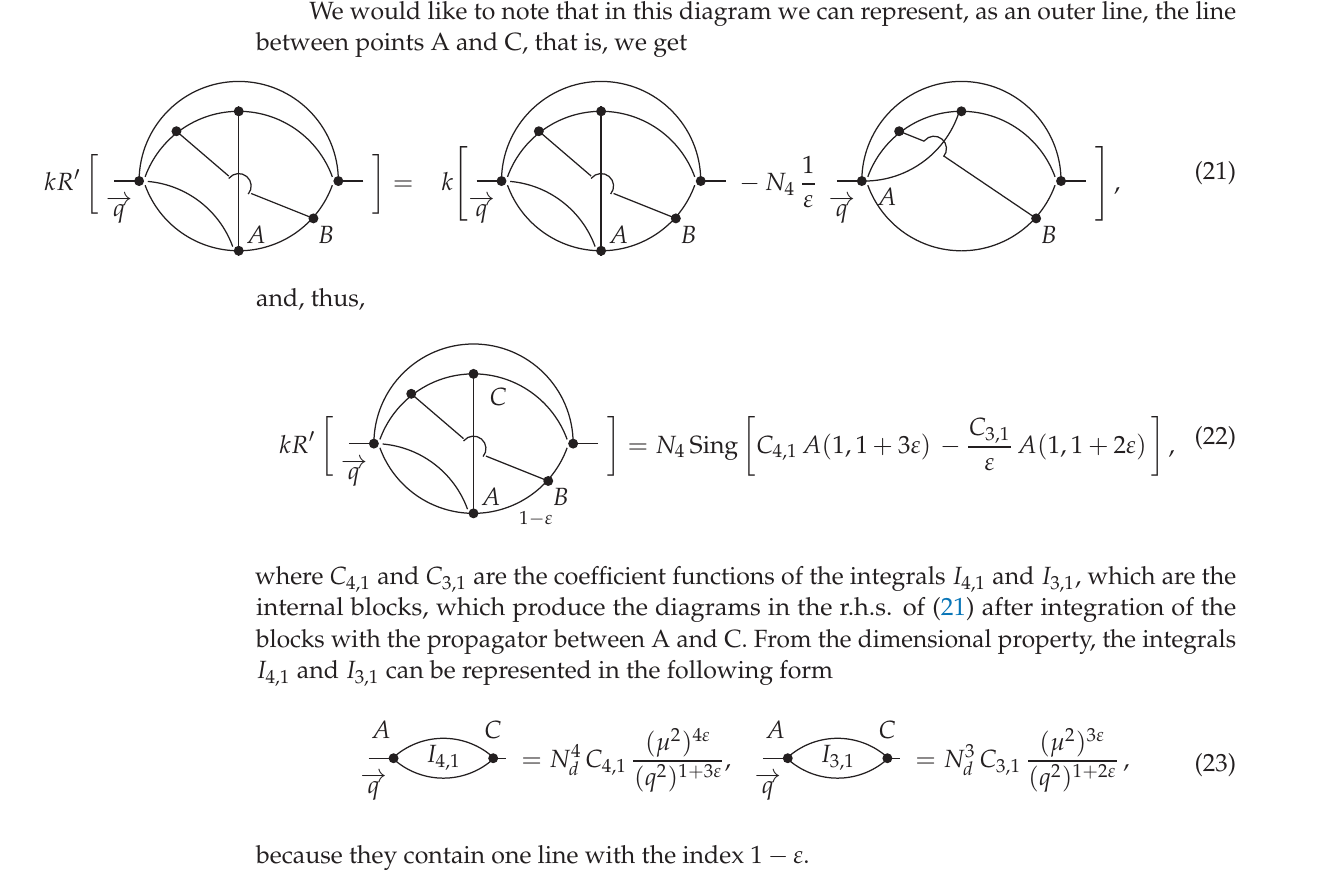
Fifth loops. Consider the fifth-loop diagram contributed to β -function of ϕ 4